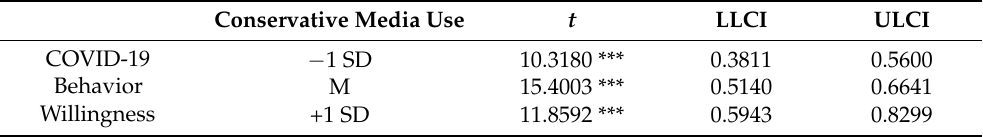
Table 1. Conditional Effects of Conservative Media Use and Media Literacy for Source on COVID-19 Behavioral